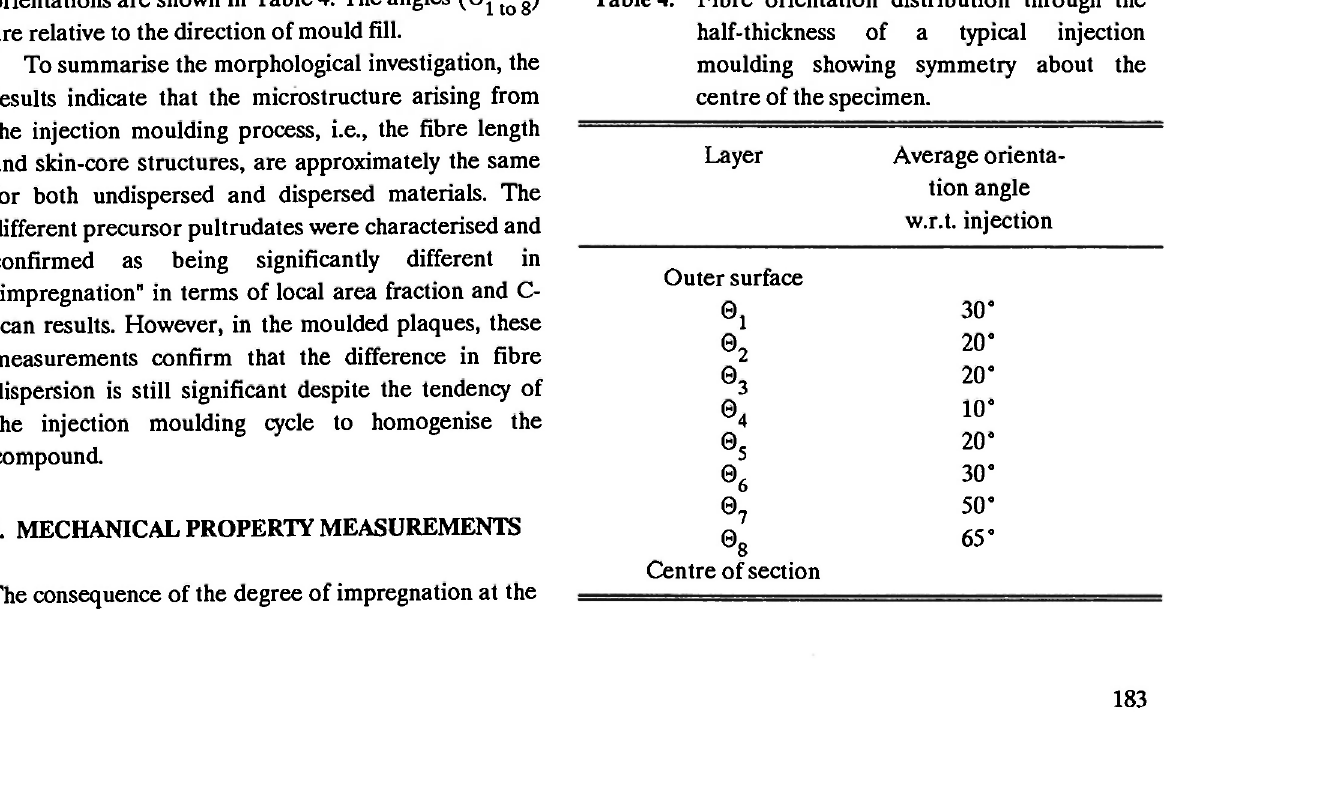
Table 4: Fibre orientation distribution through the half-thickness of a typical injection moulding showing symmetry about the centre of the